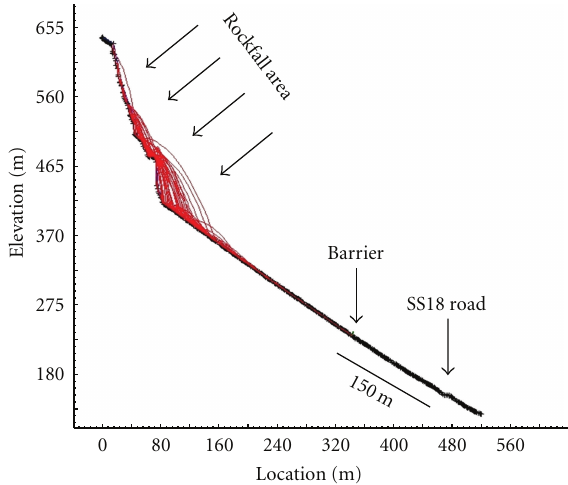
Figure 5: Example of the various rockfall layouts for profile n.10 with trajectory and protective barrier.